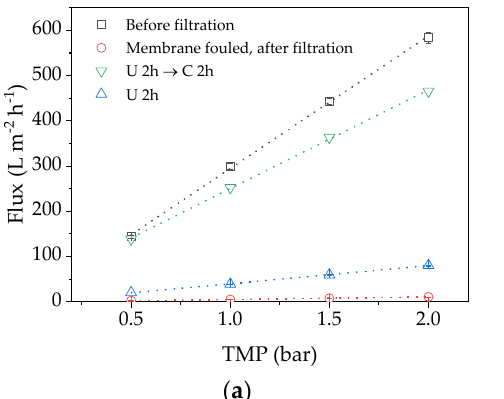
Table 5. Calculated resistance